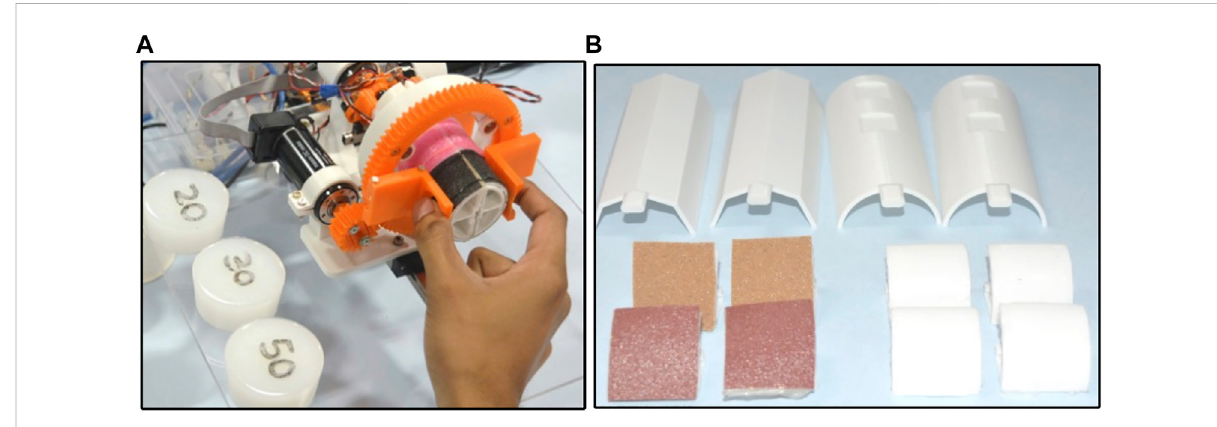
FIGURE 7 (A) Silicone specimenswith Hapticgrasper (B) Modular segmentsand textural-loading armsofthehaptic grasper.The textural loadingarmsare equipped with a variety of textures, for instance, soft fabrics, smooth and rough surfaces, and so on. The modular segments allow customization based on the application.